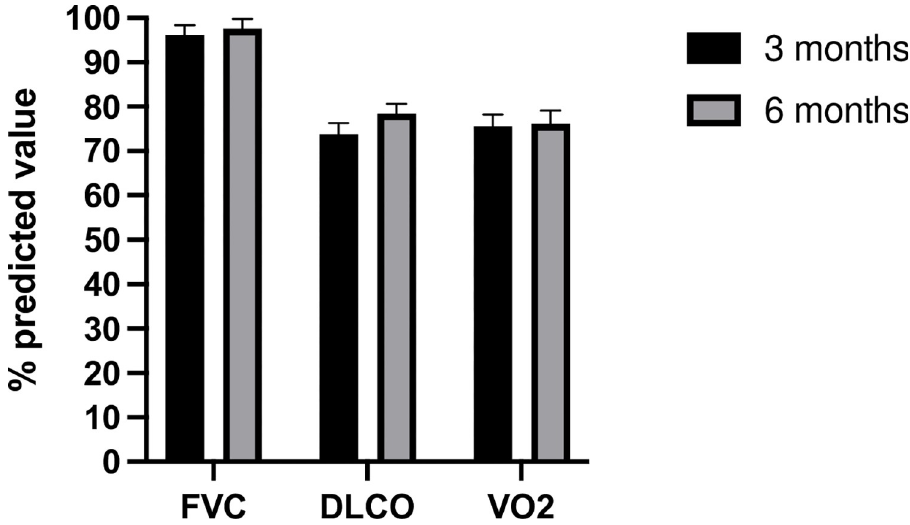
Fig 2. Percent predicted of forced vital capacity (FVC), diffuse capacity of lung for carbon monoxide (DLCO), and oxygen consumption (VO2) at 3—and 6- months following COVID-19 infection. Data is presented as mean and standard error of the mean.